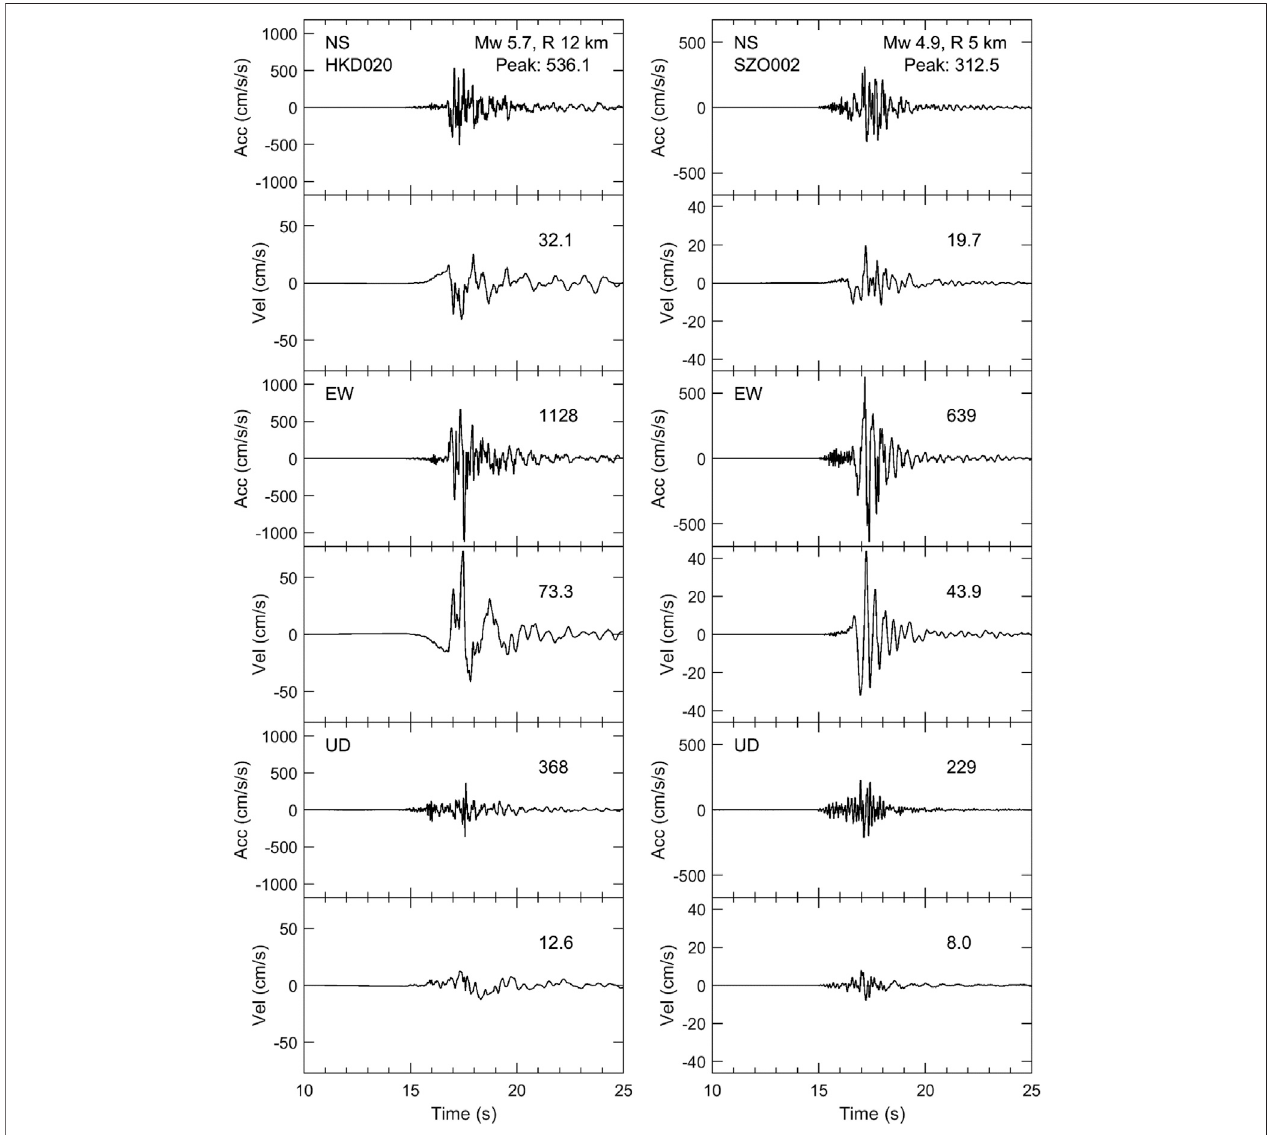
FIGURE2| Plots ofacceleration and velocity seismogramsat HKD020 sitefor anMw5.7event (leftpanel) and SZO002 siteforan Mw4.9event (rightpanel) .R denotes the hypocentral distance rounded to the closest integer. The peak values of the seismograms are written above the corresponding traces. Note the difference between the vertical scales in the left and right